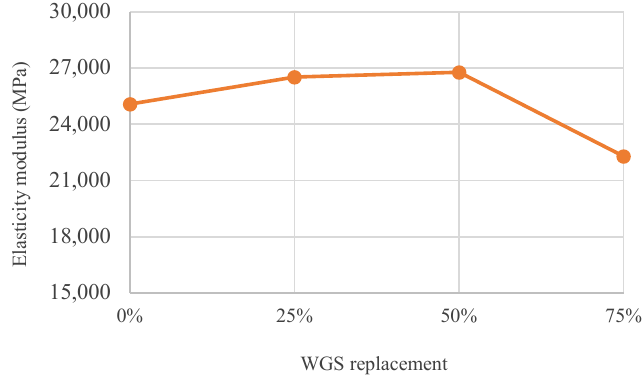
Figure 11. Elasticity Modulus Vs. Glass Sand Replacement Percentage.